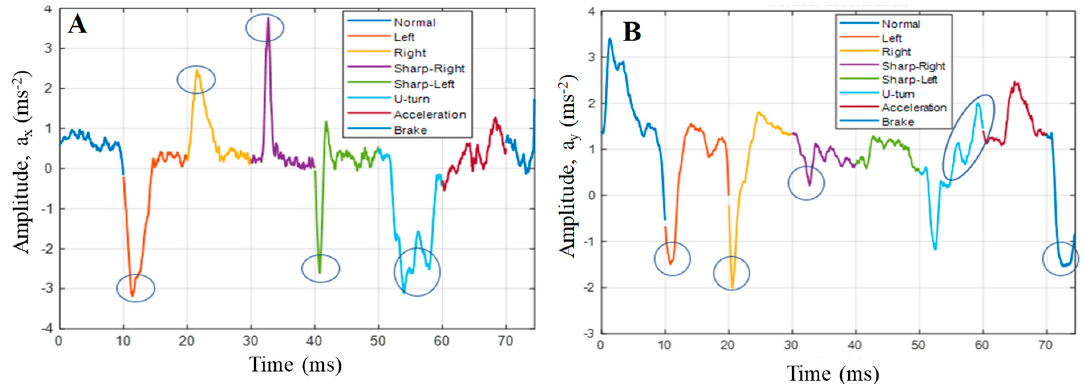
Figure 10. Average x and y data to show ( A ) left/right movements and ( B ) acceleration/braking of the vehicle.